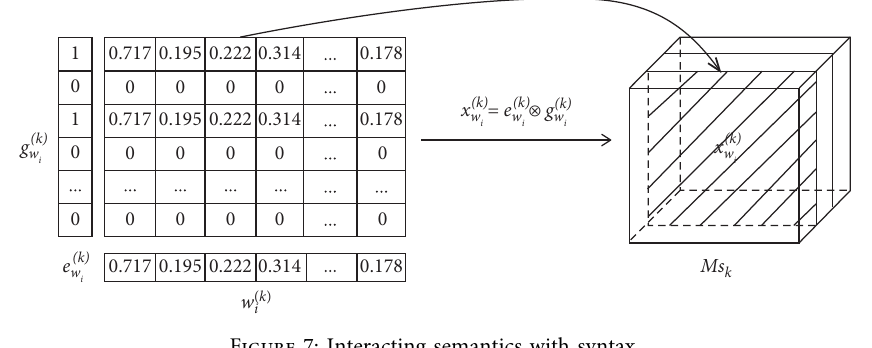
Figure 7: Interacting semantics with